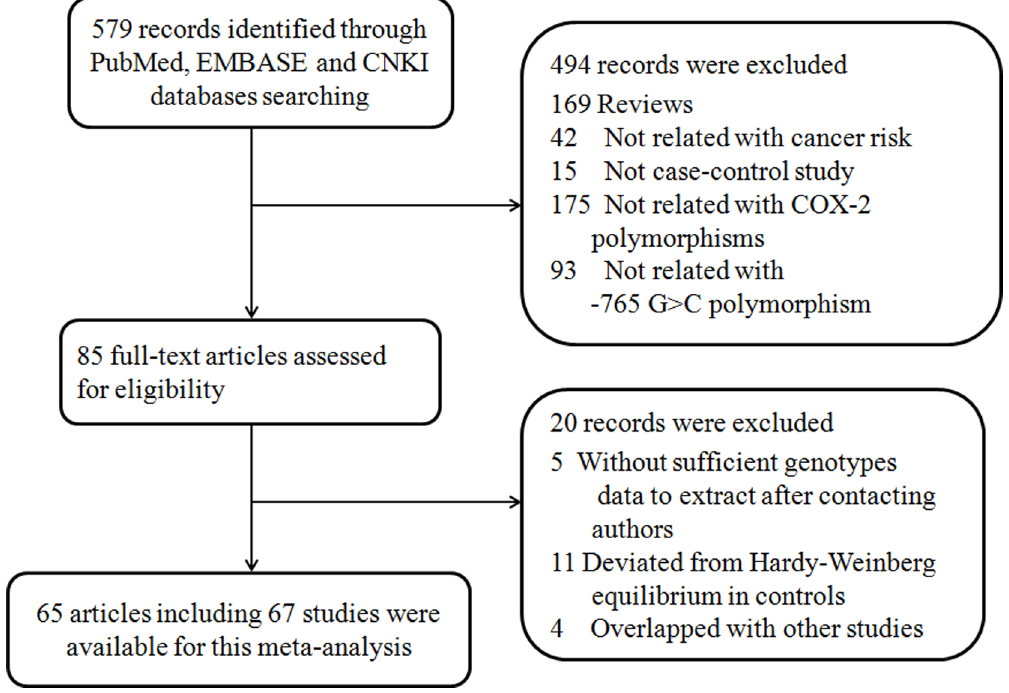
Figure 1. Flow chart of studies selected procedure of this meta-analysis.